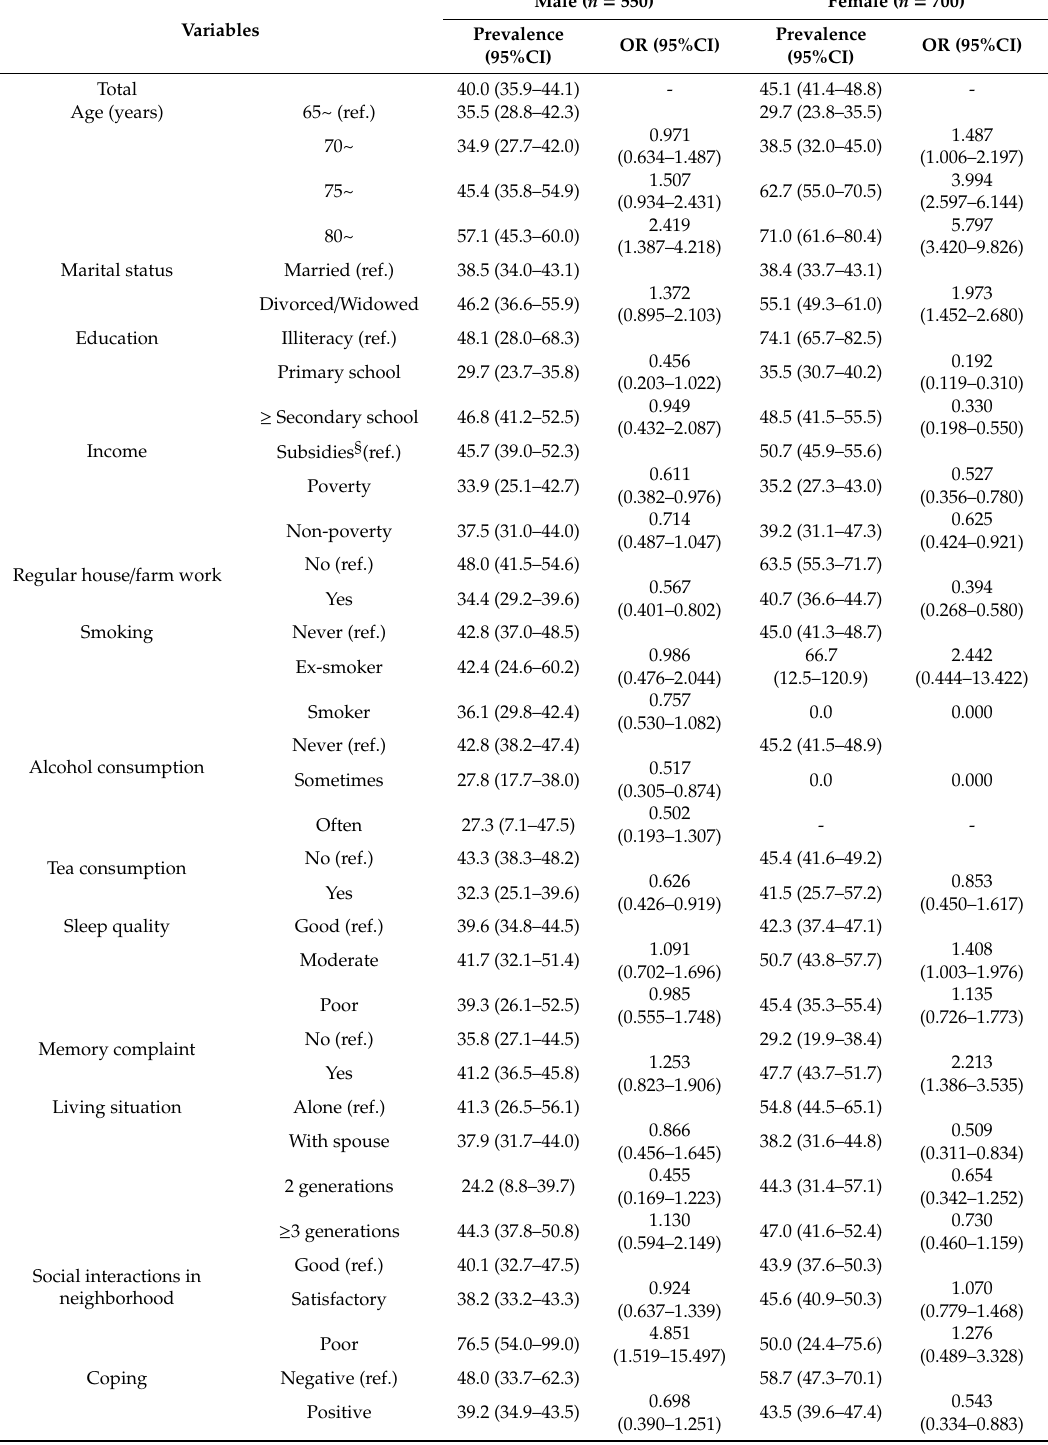
Table 4. Prevalence of cognitive impairment and univariate